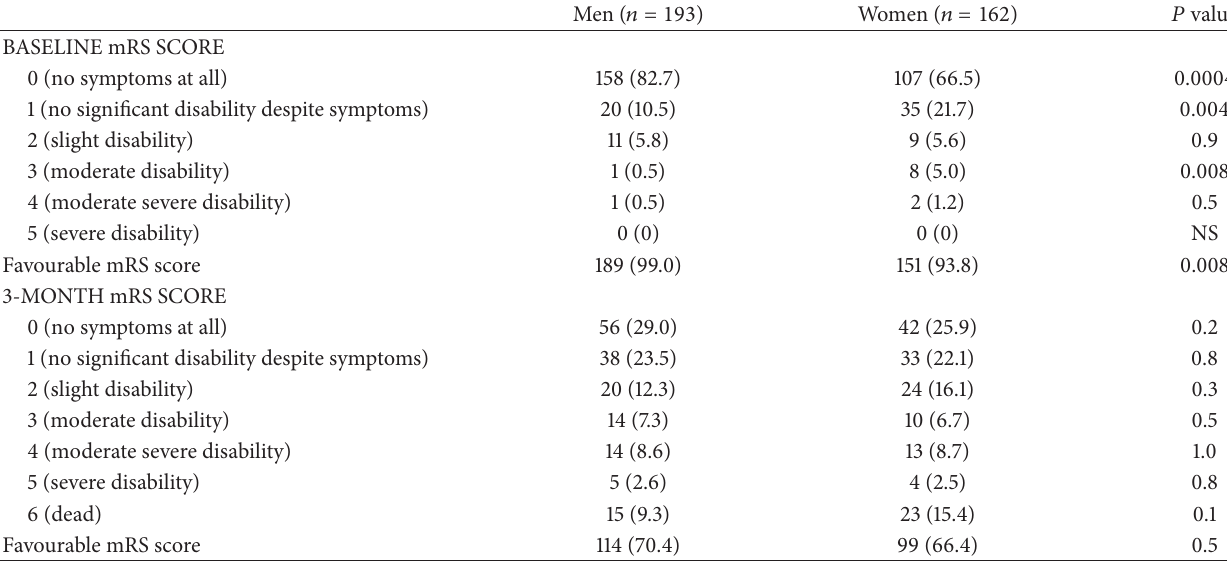
Table 2: Modified Rankin Scale score before ischemic event and 3 months after